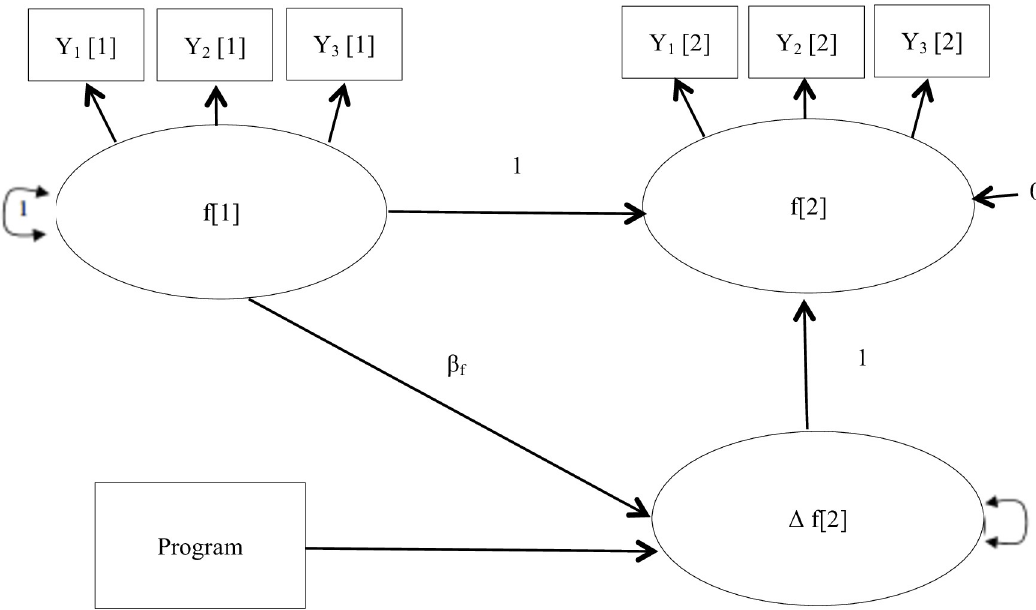
Fig 2. Example of multiple indicator univariate latent change score model and the effect of the program intervention on latent change score. Note . Disturbance of f[2] was fixed to 0 to identify the parameters of the model. f[1] and f[2] were measured using multiple indicators. In order to simplify the display of the model, covariance between indicators in wave 1 and wave 2 were not